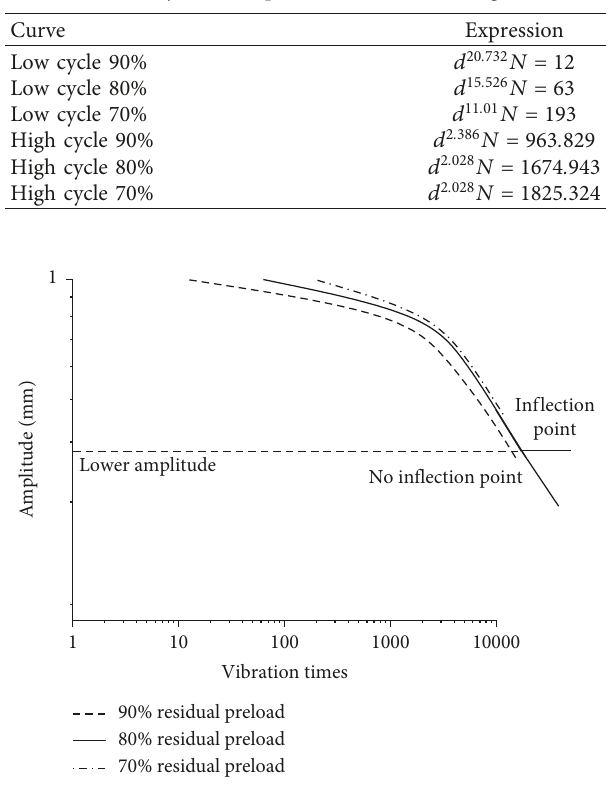
Figure 9: Infinite life dividing point of the loosening D-N